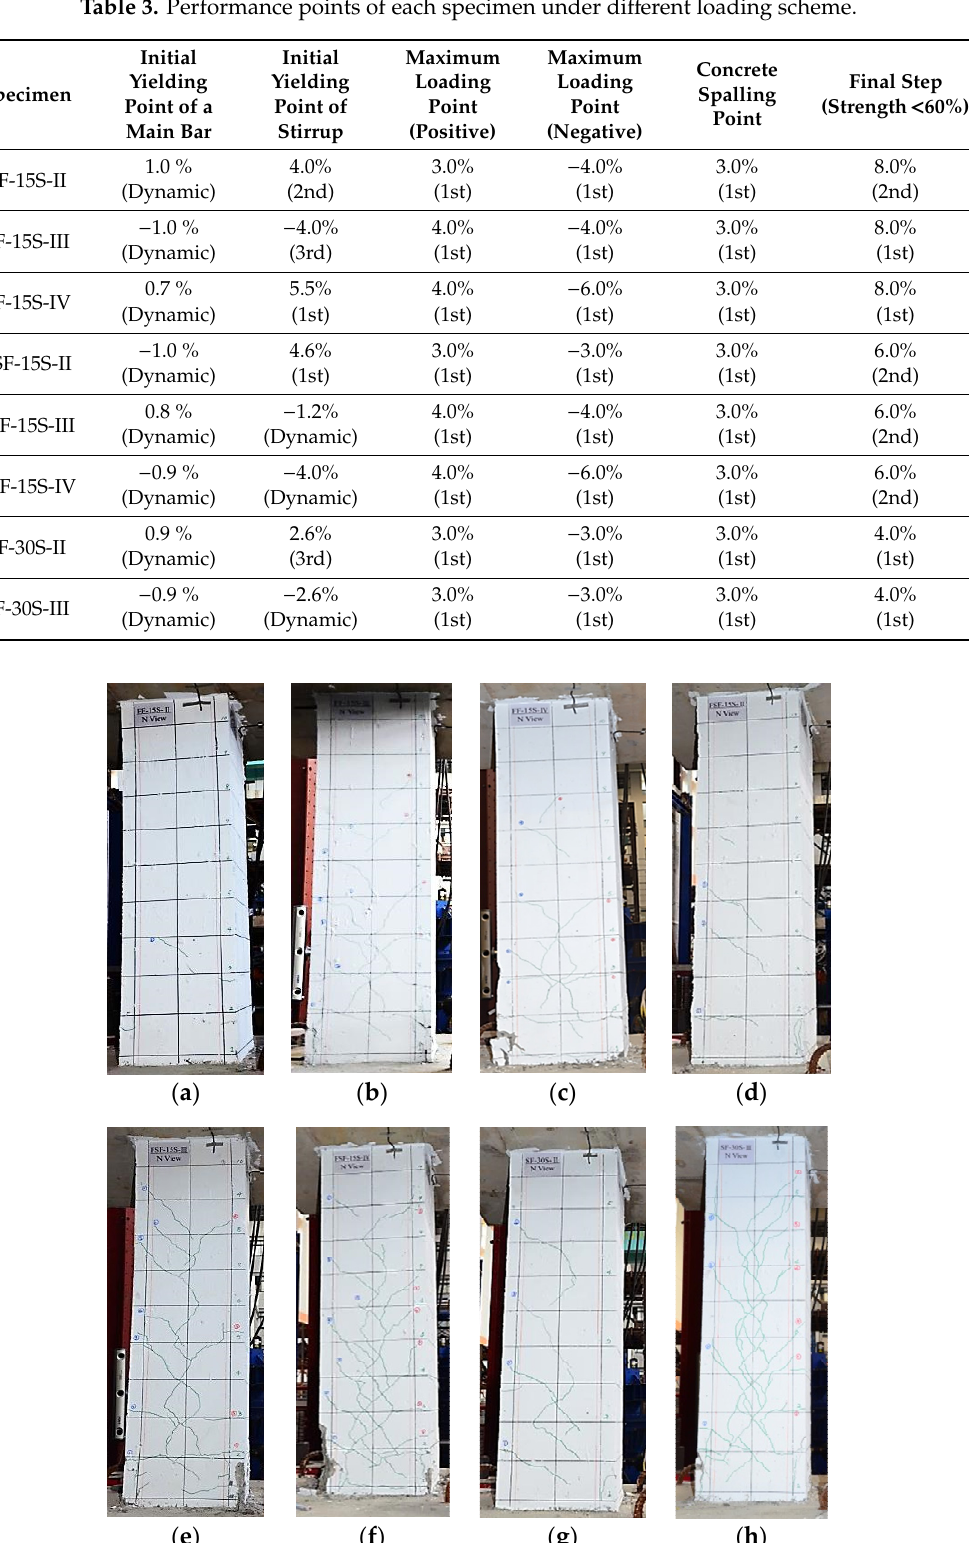
Figure 9. Damage pattern of each specimen after dynamic testing. ( a ) FF-15S-II; ( b ) FF-15S-III; ( c ) FF-15S-IV; ( d ) FSF-15S-II; ( e ) FSF-15S-III; ( f ) FSF-15S-IV; ( g ) SF-30S-II; ( h ) SF-30S-III .